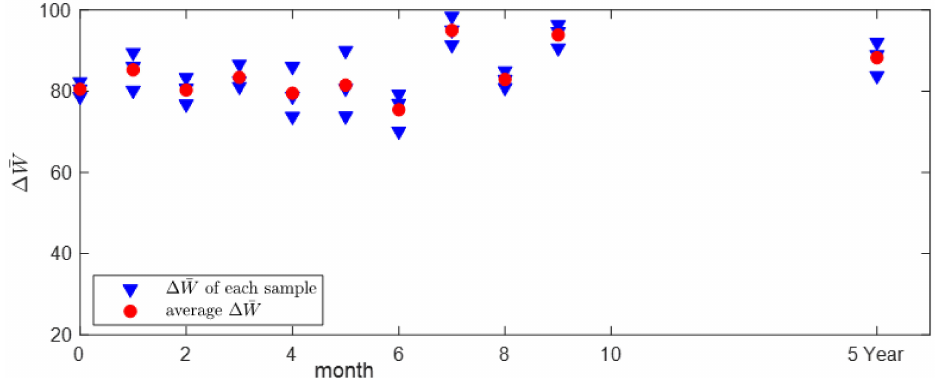
Figure 5. Dissipated energy per cycle during the testing